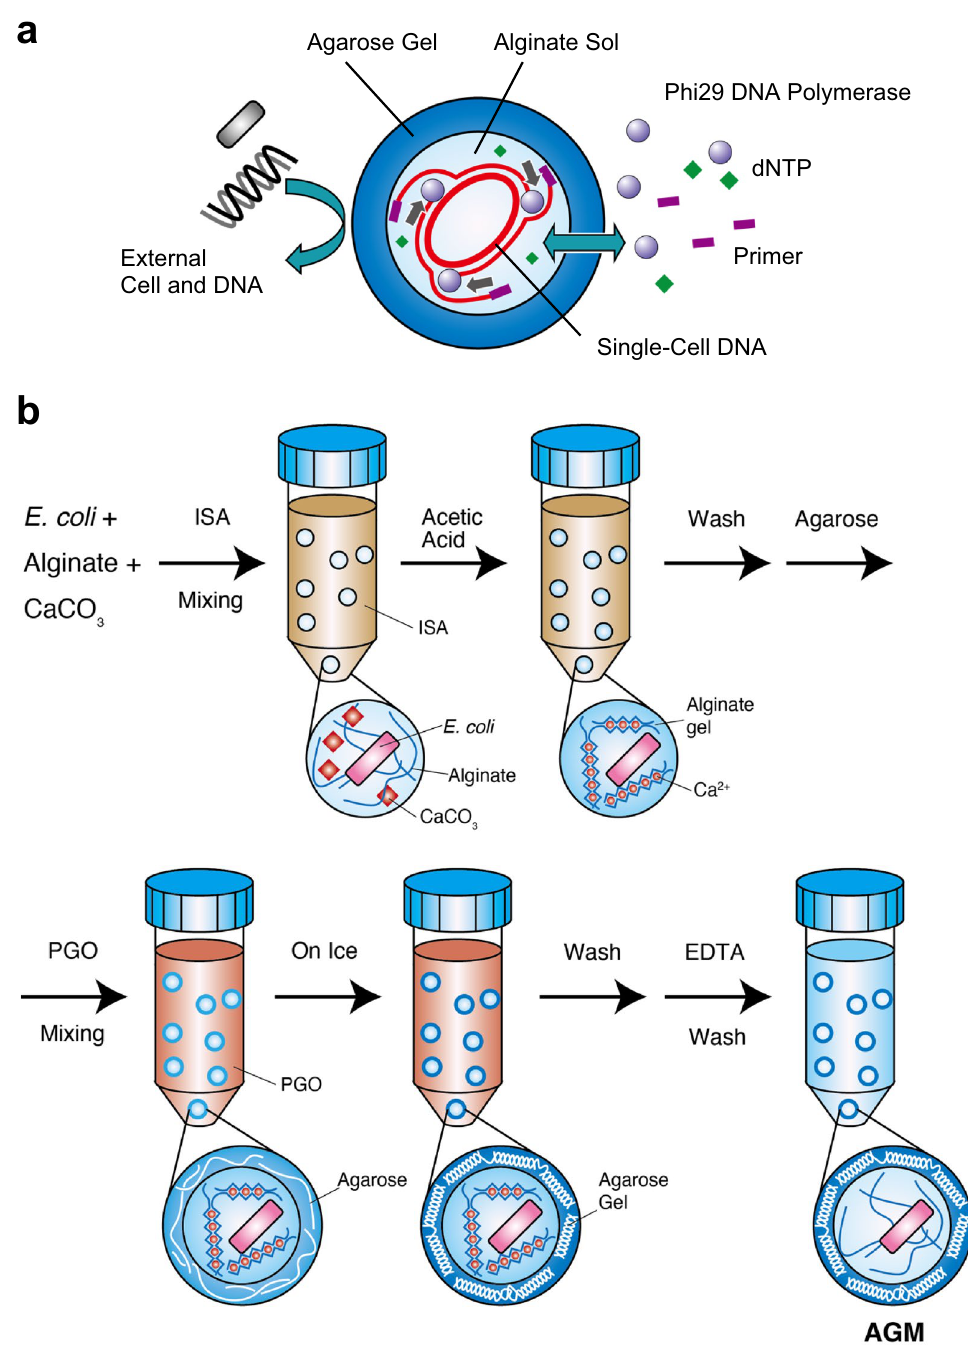
Figure 1. Schematic view of an agarose gel microcapsule (AGM) and its preparation process. ( a ) Schematic diagram of the AGM developed in this study for single-cell isolation and multiple displacement amplification (MDA). The AGM consists of an agarose hydrogel shell and an alginate sol core. The alginate core provides a picolitre-scale reaction chamber for MDA, while the agarose shell acts both as a permeable envelope for enzymes and small molecules and as a protective wall against larger particles and molecules such as bacterial cells and genomic/amplified DNA. ( b ) Preparation scheme for AGMs containing Escherichia coli cell(s). The alginate cores and agarose shells are gelated with Ca 2+ from CaCO 3 and cooled in an emulsion, respectively. Polyglyceryl-6 octacaprylate (PGO) can suppress the aggregation of AGMs during agarose gelation by cooling. Finally, the alginate gel cores are solated with EDTA by chelating Ca 2+ . ISA isostearyl